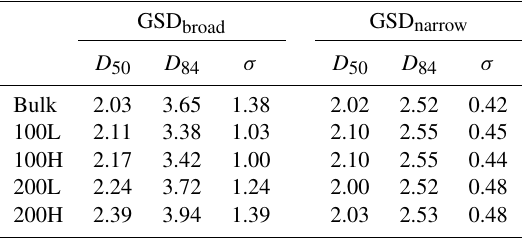
Table 5. Grain size statistics of output material, averaged over the total output mass and given in millimetres (mm). GSD broad GSD